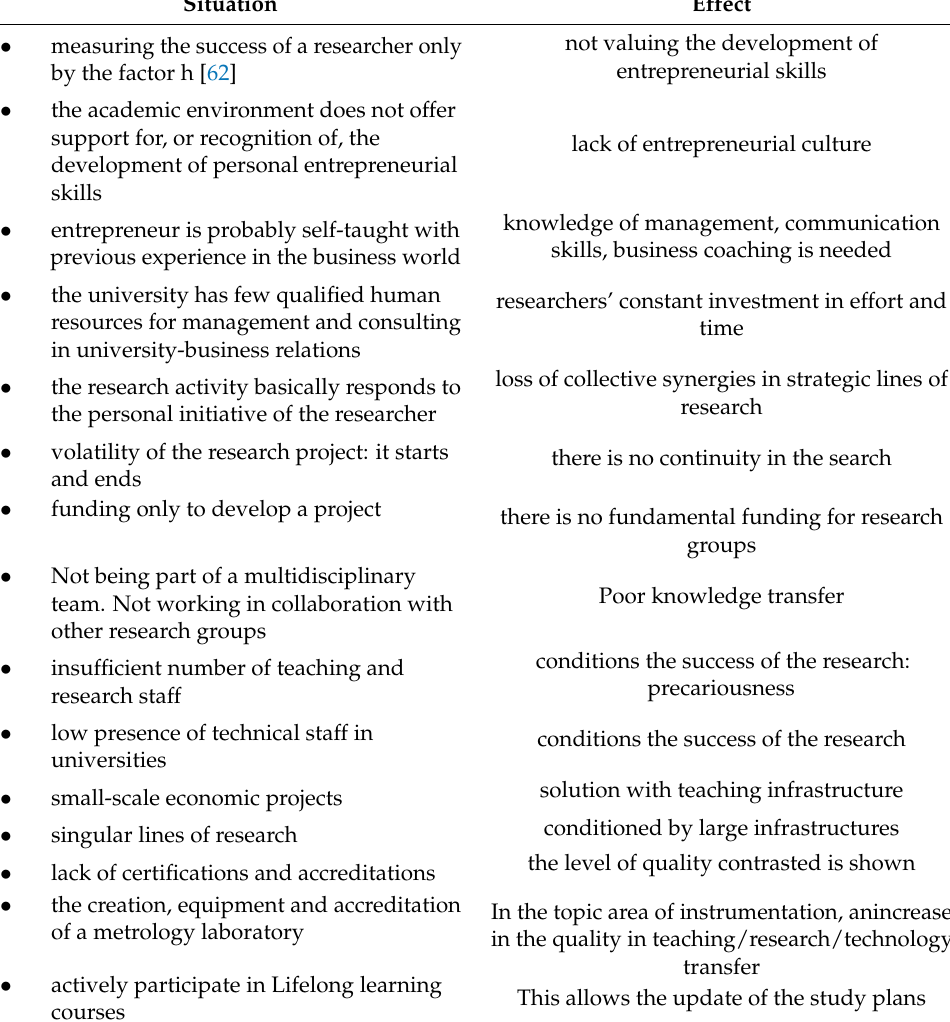
Table 16. Some points to consider for the development of a research